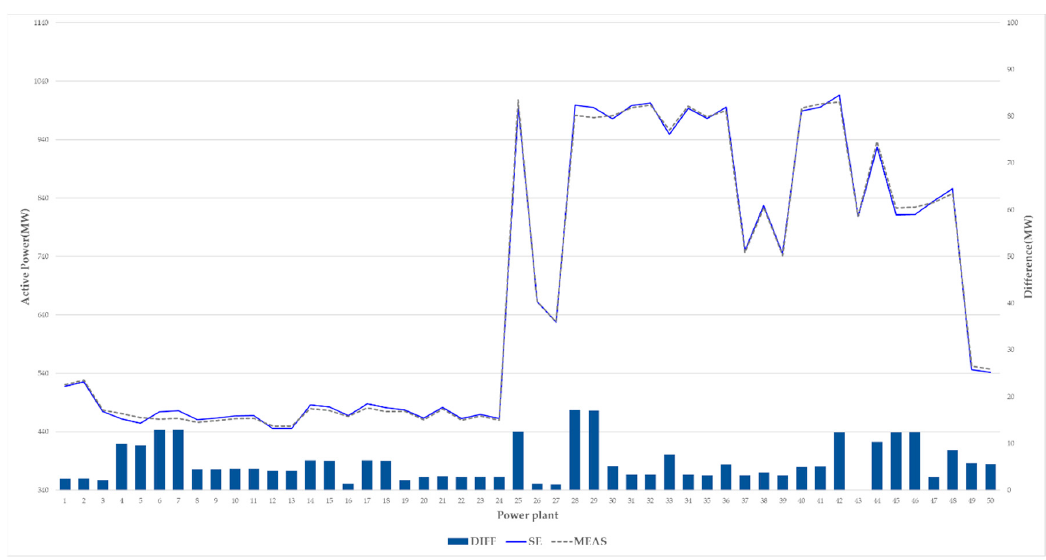
Figure 12. Generation for the estimation results and measurements of the 50 largest units.